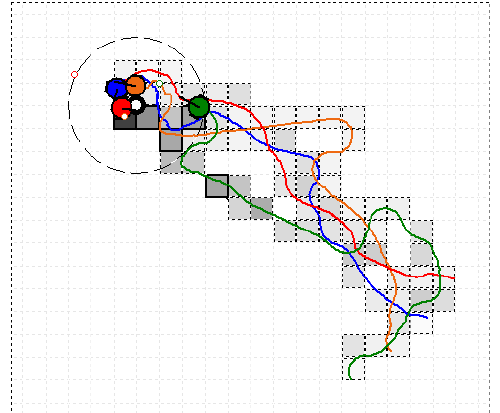
Figure 12. One of recorded CPT processes in the natural airflow field of Arena I using the AACO+US strategy (four robots were